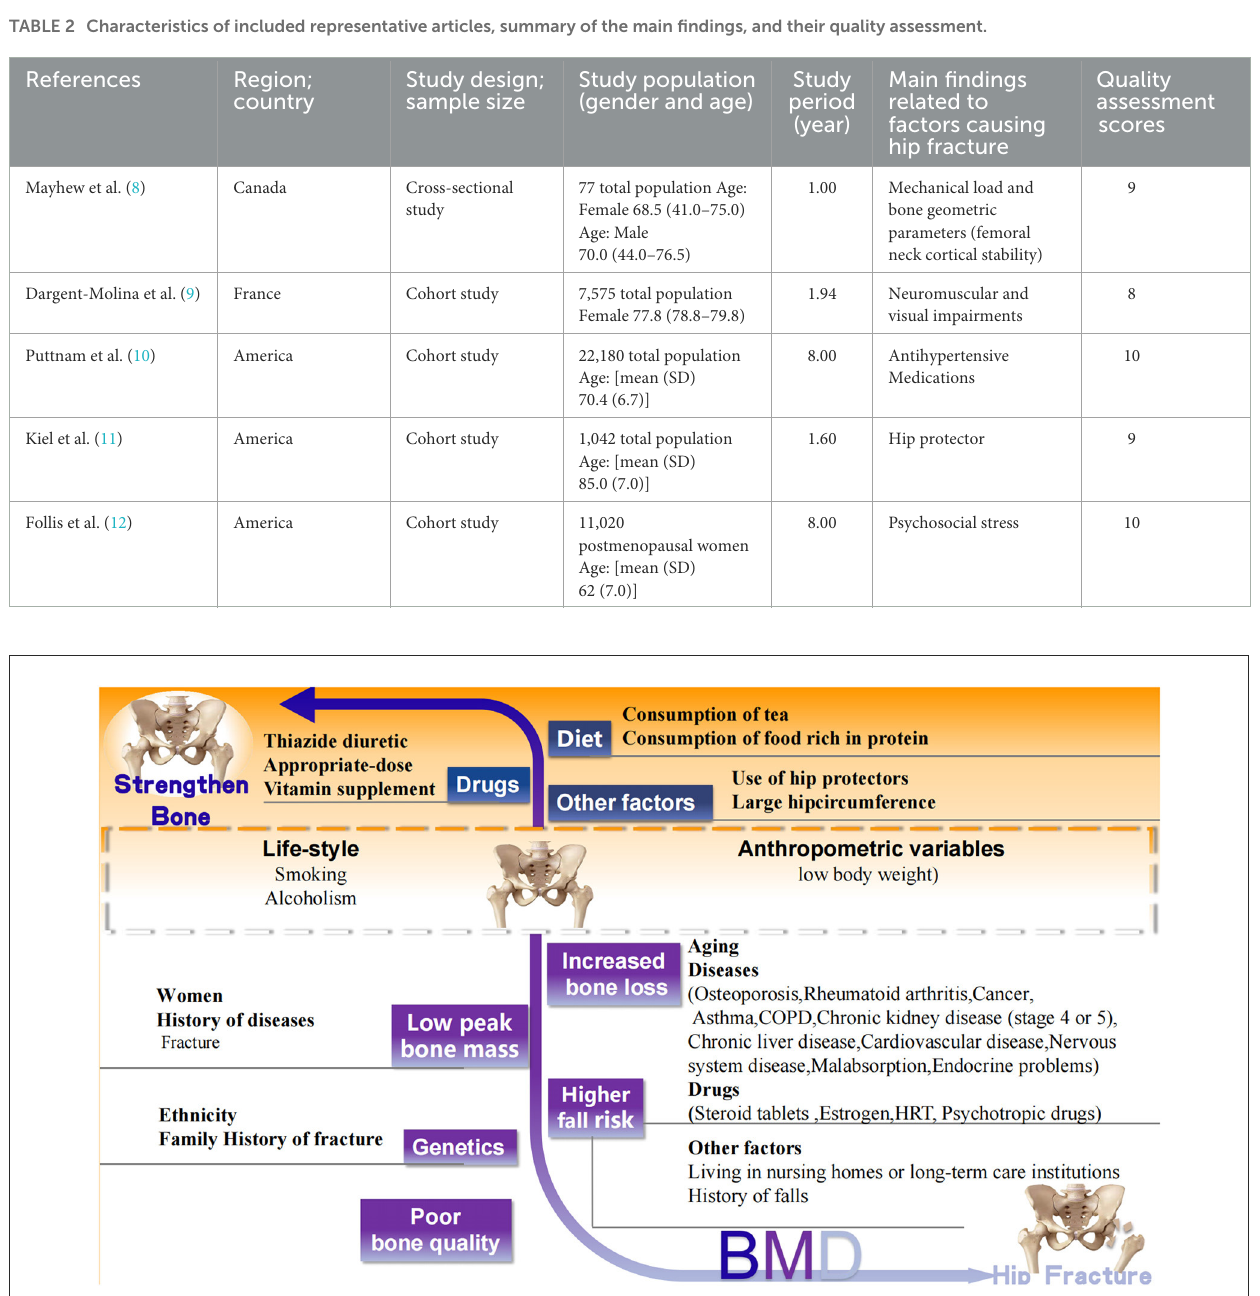
FIGURE2 Well-accepted factors associated with hip fracture. Black words: well accepted risk (white background) and protective (orange background) factors related to hip fracture. CODP, chronic obstructive pulmonary disease; HRT, Hormone replacement therapy.